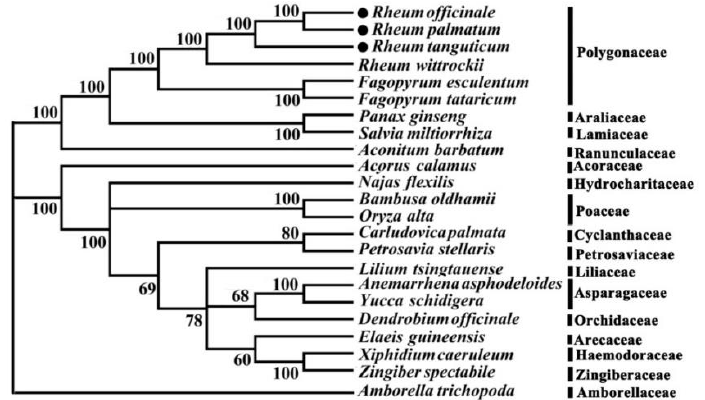
Figure 3. Phylogenetic tree constructed using neighbor joining (NJ), based on the whole chloroplast genomes from different species. Amborella trichopoda was set as outgroup.